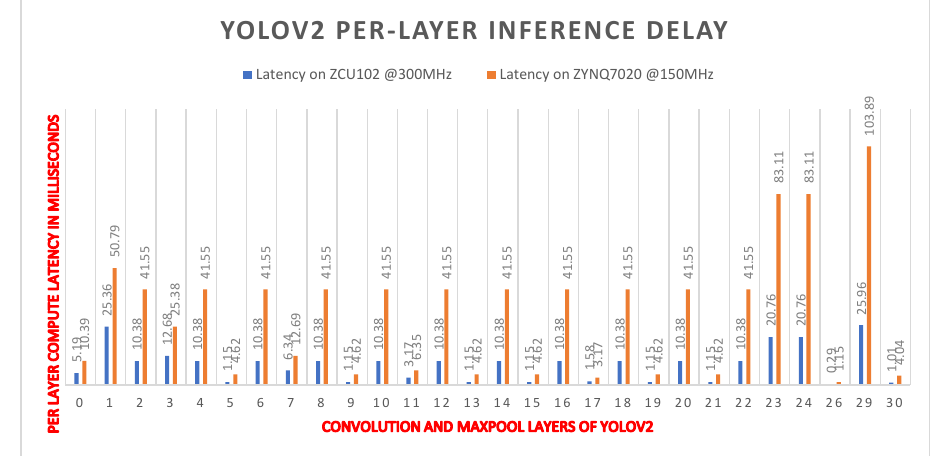
Figure 12. Per-layer latency of YOLOv2 inference on ZYNQ 7020 and